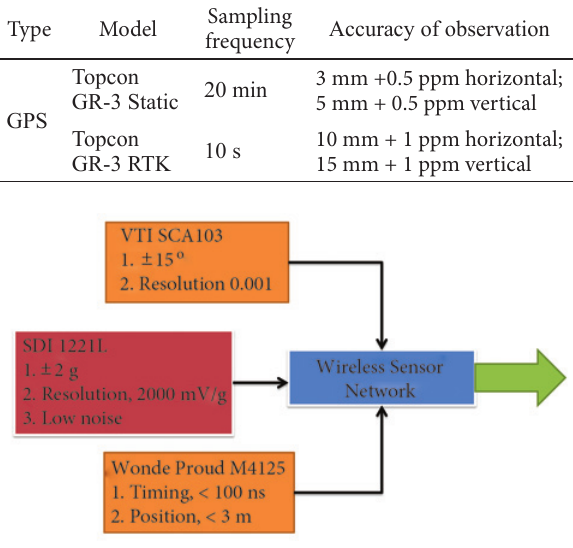
Fig. 1. Integration module of